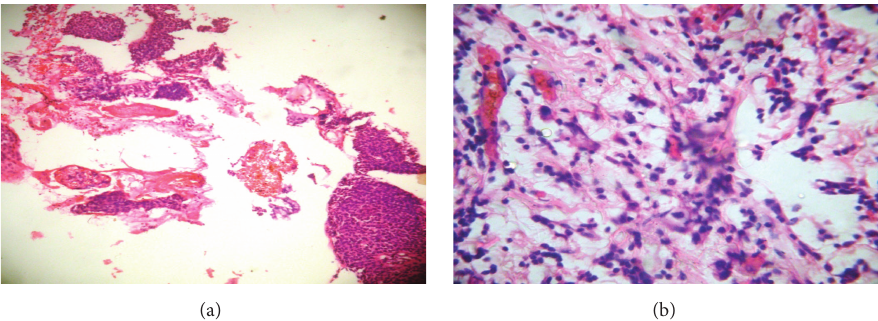
Figure 2: (a) Photomicrographs of trucut biopsy before NAT (H&E × 100). (b) Same case after receiving NAT showing a pCR (H&E × 400).